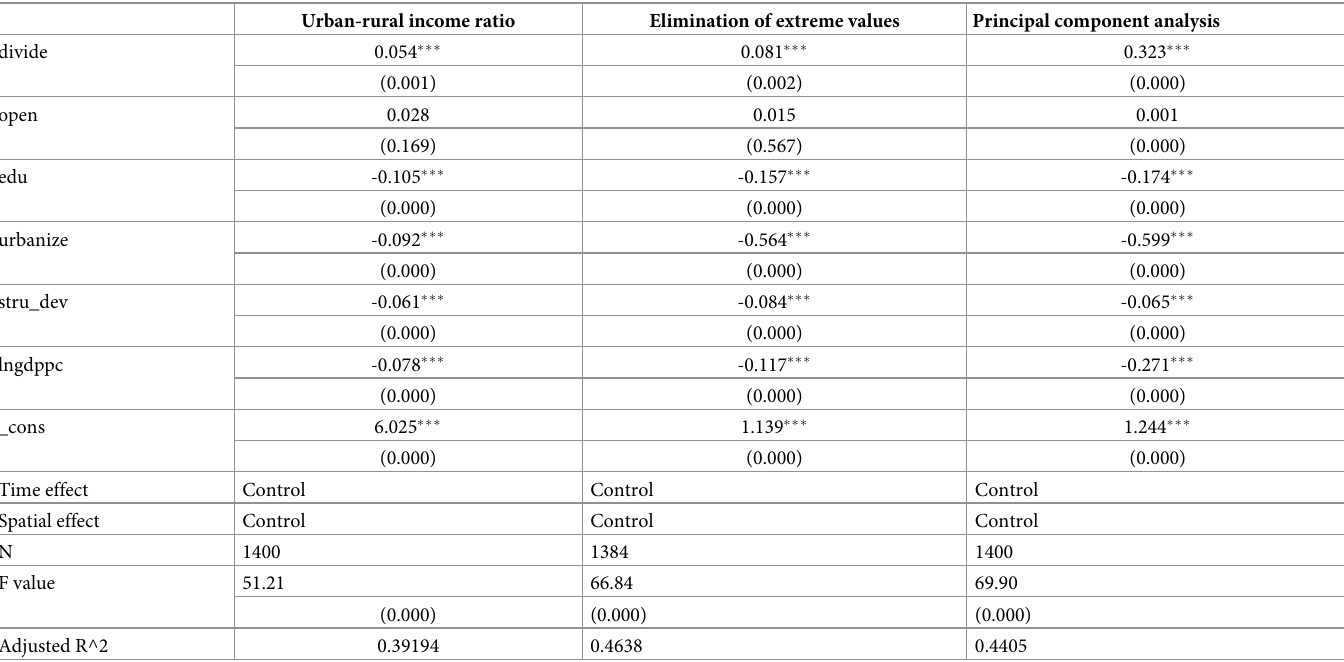
Table 7. Robustness test.